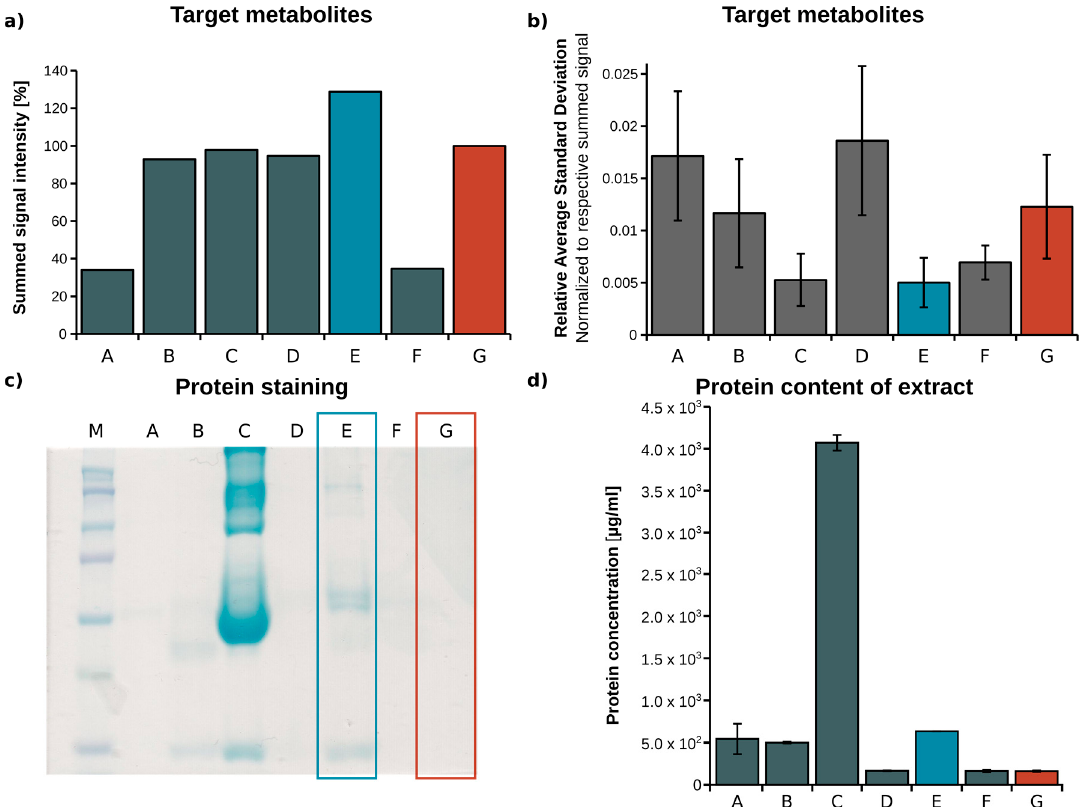
Figure 1. Optimization of the metabolite extraction protocol from plasma—( a ) Summed sample signal intensity (peak area) of all target metabolites; ( b ) relative average standard deviation of all target metabolites in relation to respective summed signal; ( c ) SDS-PAGE and Coomassie staining of plasma extracts; ( d ) protein concentration of plasma extracts (A—isopropanol/acetone 1:2, B—methanol, C—